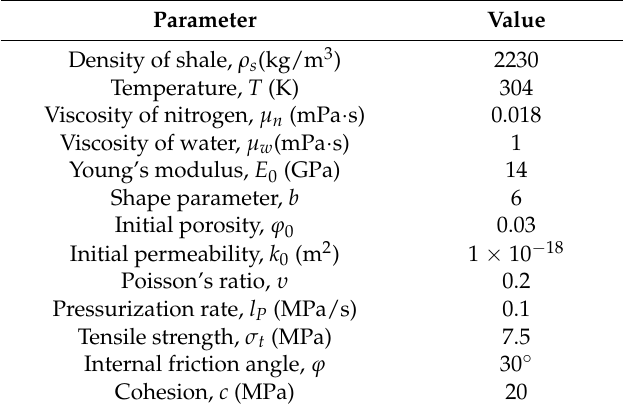
Table 2. Computational parameters of heterogeneous shale.